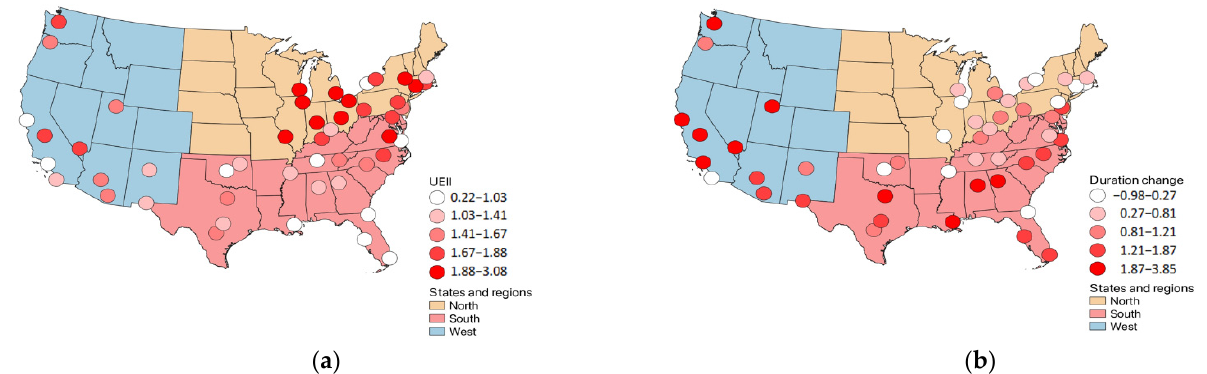
Figure 3. The relationship between UEII and duration change values; ( a ) spatial pattern of UEII values; ( b ) spatial pattern of duration change values.